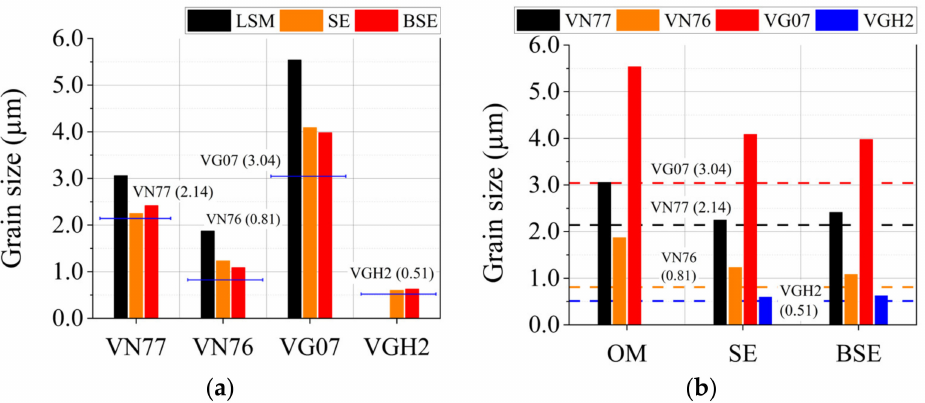
Figure 8. Results obtained by area analysis (AA) of: ( a ) the grain size vs. cemented carbide grades, and ( b ) the grain size vs. image acquisition.